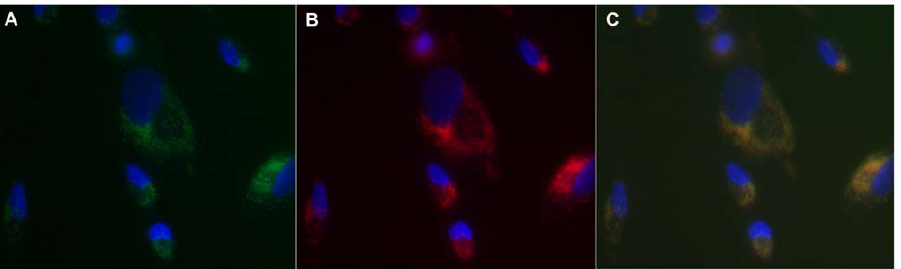
Figure 9. Cellular uptake of preloaded h 9 h 5 -vesicles. (A–C) h 9 h 5 -vesicles with one of the peptides labeled (bis(h 5 )-K-K 4 labeled with Carboxytetramethylrhodamine) and loaded with 5(6)-Carboxyfluorescein were delivered to N/N 1003A rabbit lens epithelial cells. Green and red filter settings were used for the detection of 5(6)-Carboxyfluorescein (A) and Rhodamine labeled peptide (B) respectively. (C) is a merge of a & b showing co-localization of dye and h 9 h 5 -vesicles within the